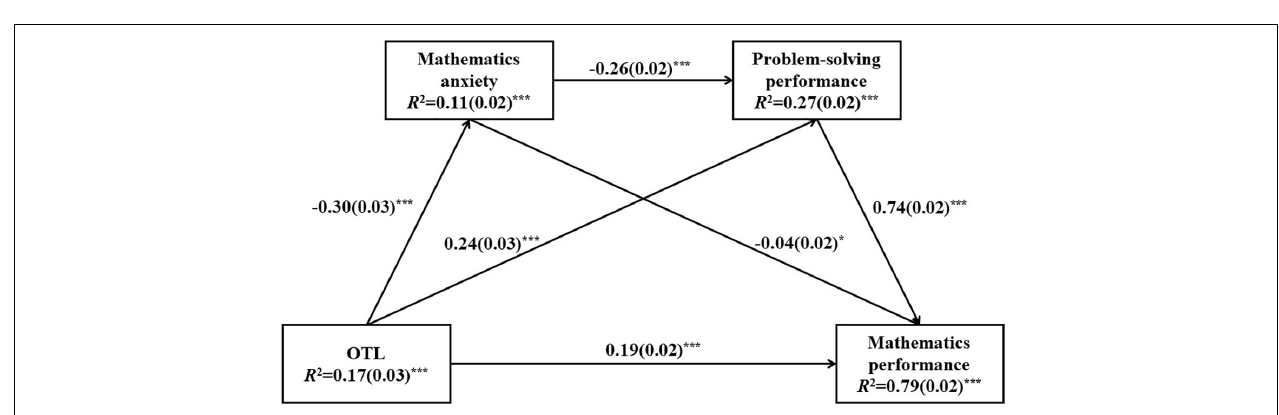
FIGURE 3 | Sequential mediation model of opportunity to learn (OTL) as a predictor on student mathematics performance in United States. Standardized path coefficients (Beta) are displayed for all paths. Standard errors are reported in parentheses. *** p < 0.001; ** p < 0.01; * p < 0.05.